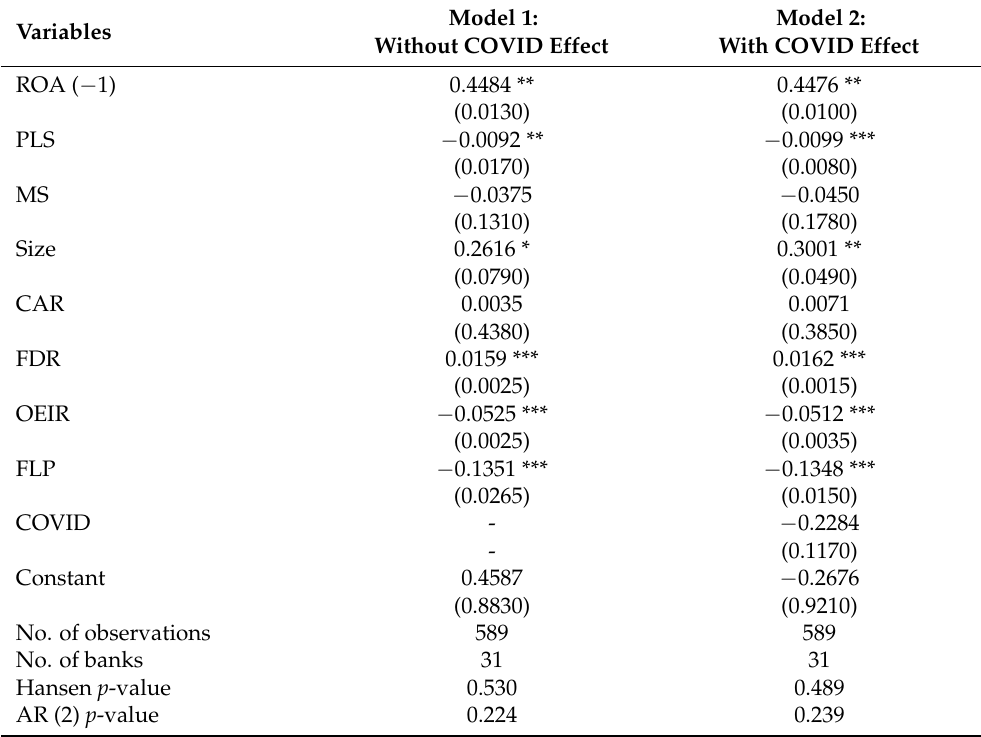
Table 4. ROA-PLS relationship: ratio of PLS financing to total